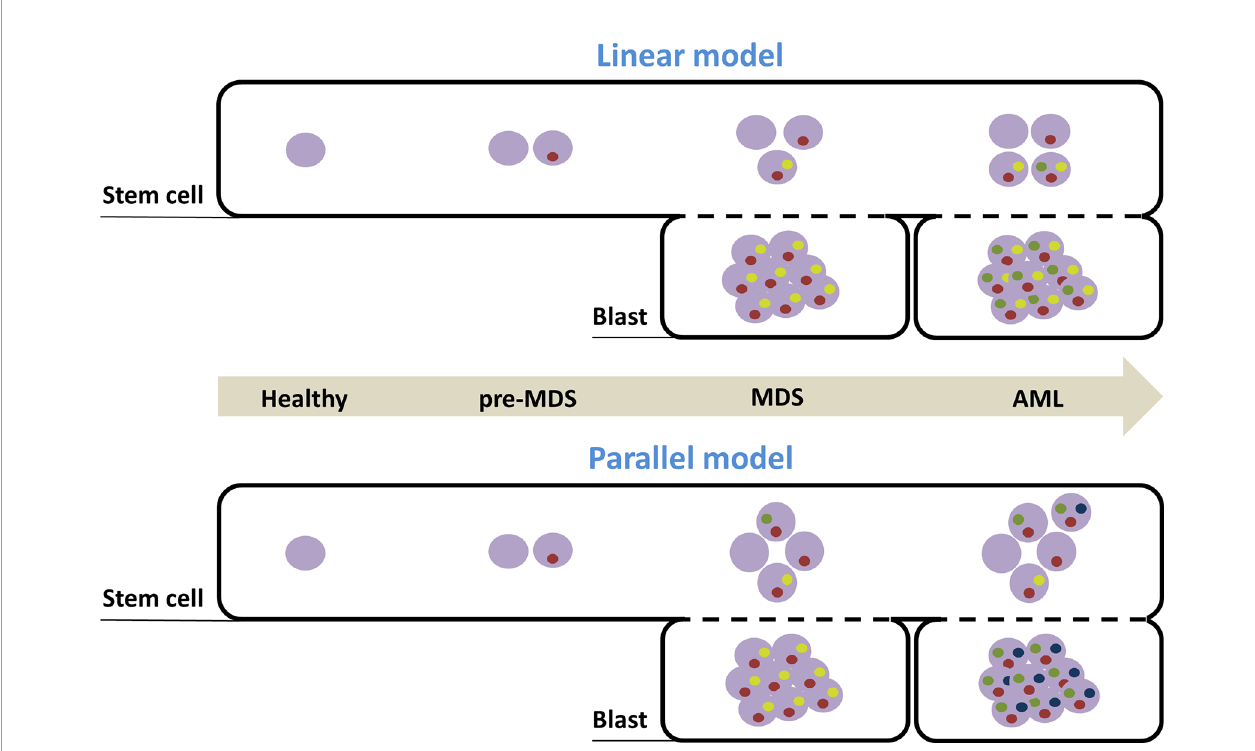
FIGURE 1 | Models of clonal evolution accounting for MDS development and AML transformation. Distinct temporal stages of disease progression are represented with the arrow. Healthy cells are depicted by an empty purple circle. Inside purple circles, each colored circle (yellow, red, blue and green) symbolizes the presence of a distinct mutation. Combination of mutations de fi nes speci fi c clones. According to the linear model, clonal evolution in the stem cell compartment is simply sequential and cumulative and the dominant clone in MDS stage (found in the blast compartment) initiates AML, after acquisition of new mutations. According to the second model, pre-MDS-SCs acquire distinct additional mutations in parallel, that drive either MDS blast production or AML transformation. MDS, myelodysplastic syndrome; AML, acute myeloid leukemia; SC, Stem